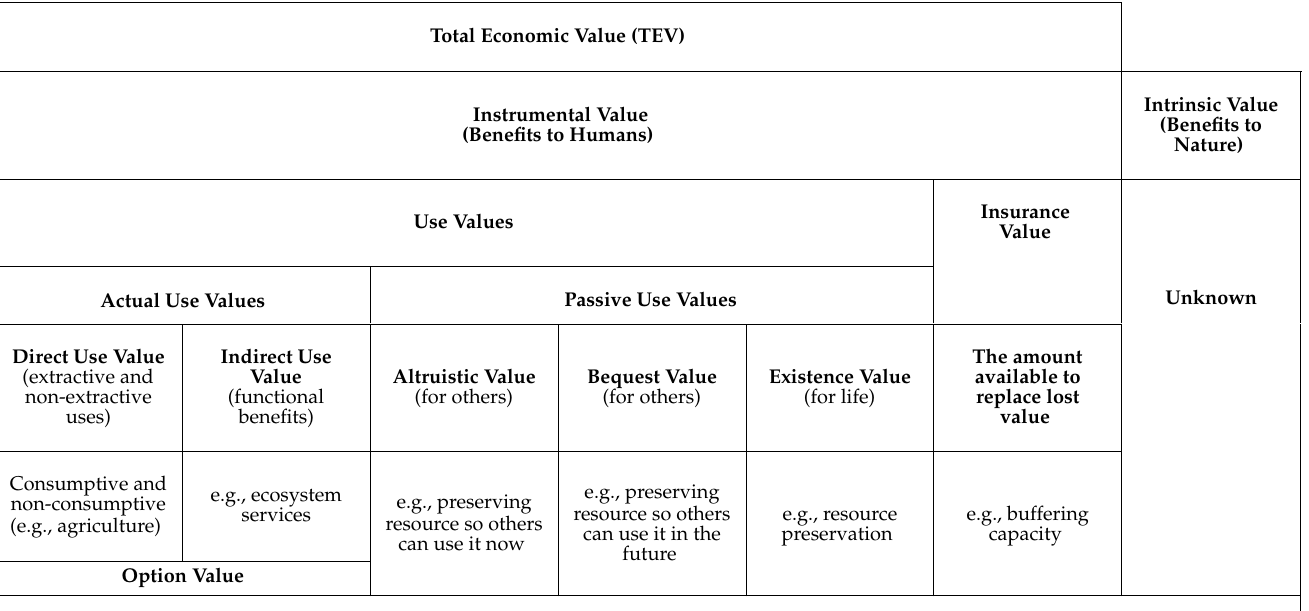
Table 3. The total economic value (TEV) framework with insurance value (adapted from Nimmo-Bell (2011) [31], NZIER, 2018 [32], Baveye et al., 2016 [18], and Bartkowski et al., 2020 [20]).